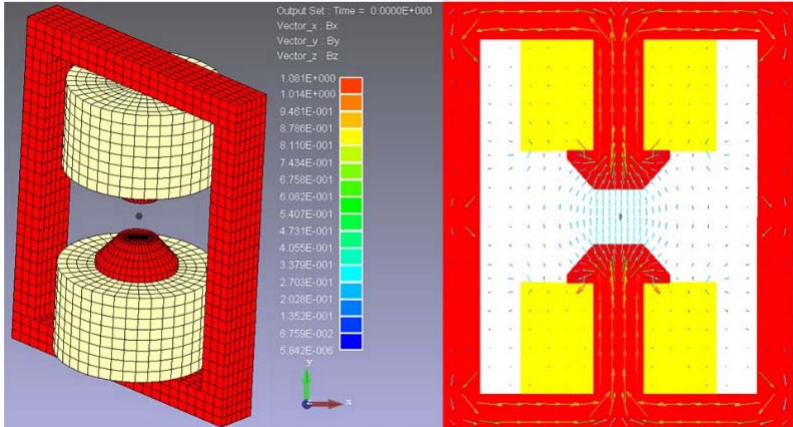
Figure 9. The designed external magnetic field simulation results. Table 2. The dimensions of the designed external magnetic field.